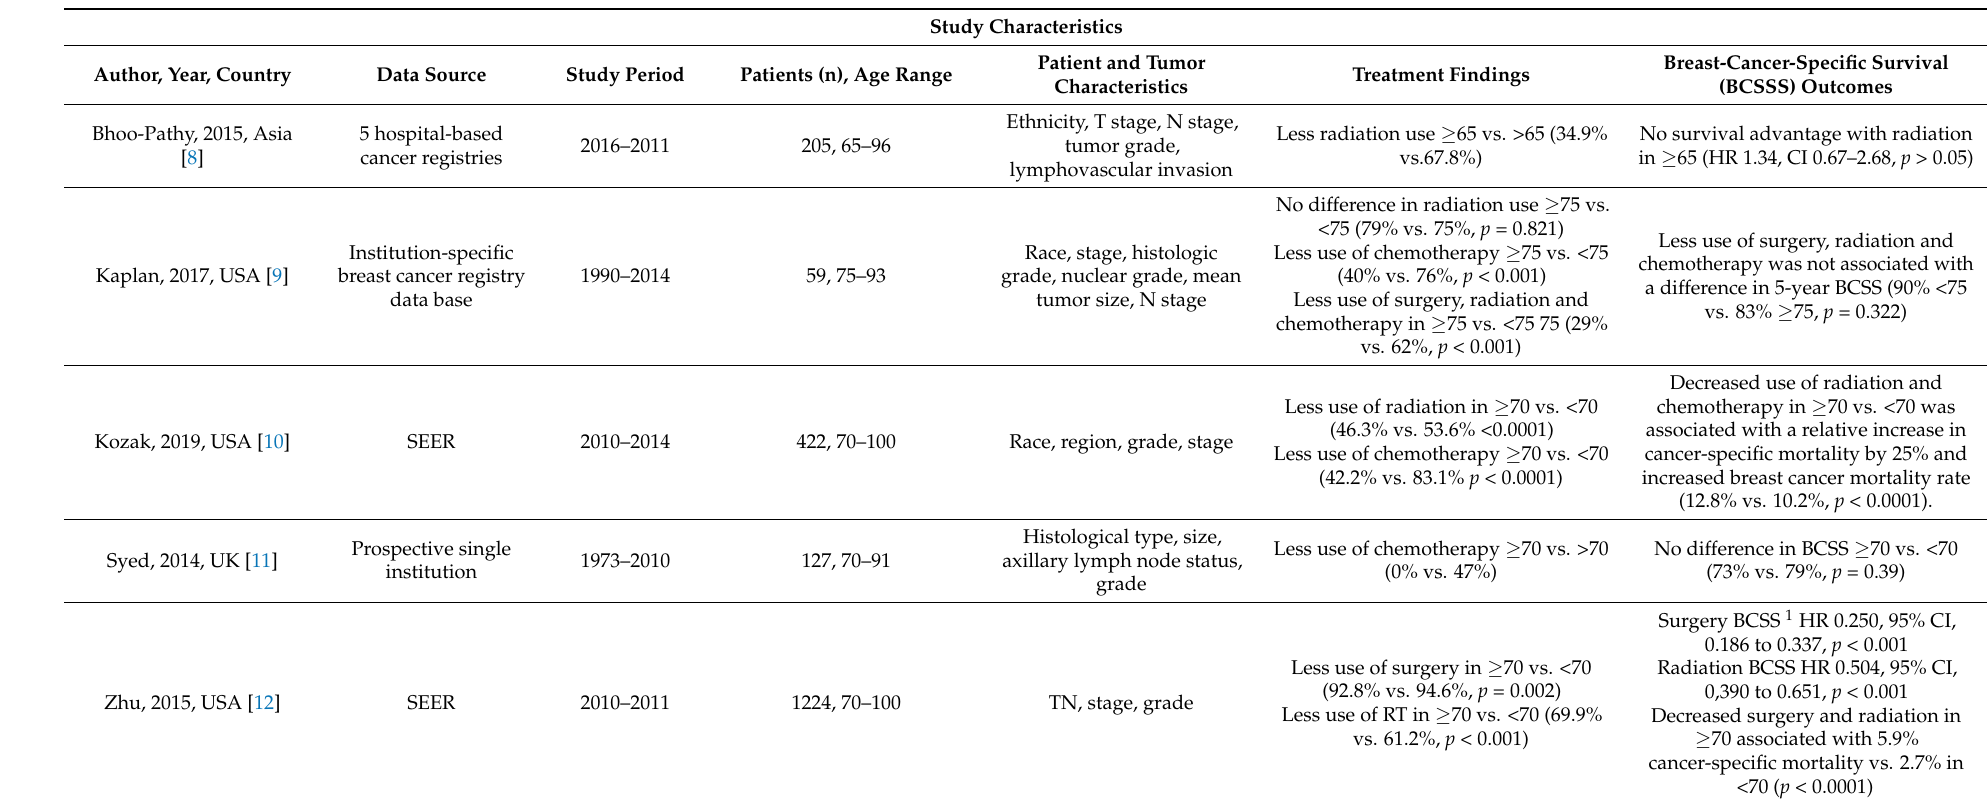
Table 2. Study characteristic table of included